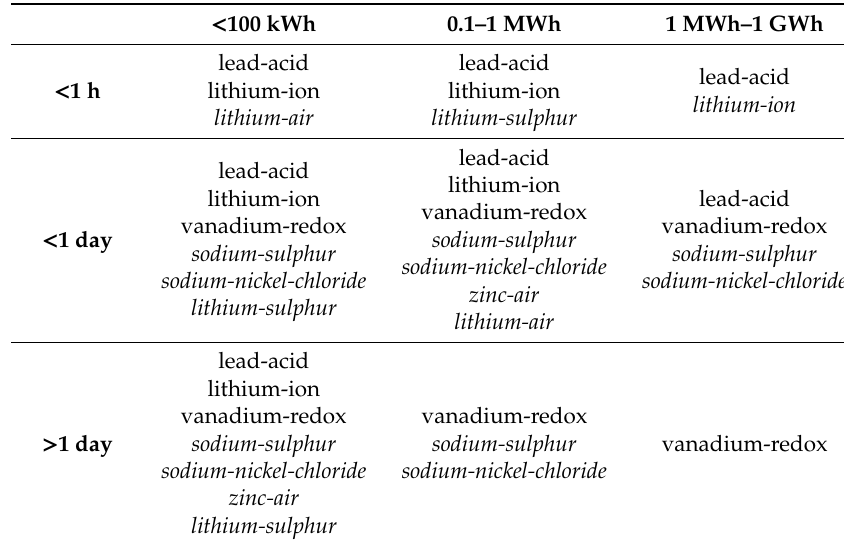
Table 1. Battery storage